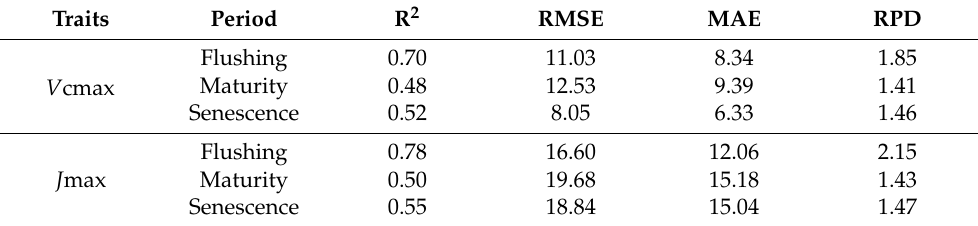
Table 1. Performance results for predicting the maximum carboxylation rate ( V cmax) and maximum electron transport rate ( J max) using the ensemble DNN model during different growing periods (flushing, maturity, and senescence). R 2 : coefficient of determination; RMSE: root mean square error; MAE: mean absolute error; RPD: ratio of performance to standard